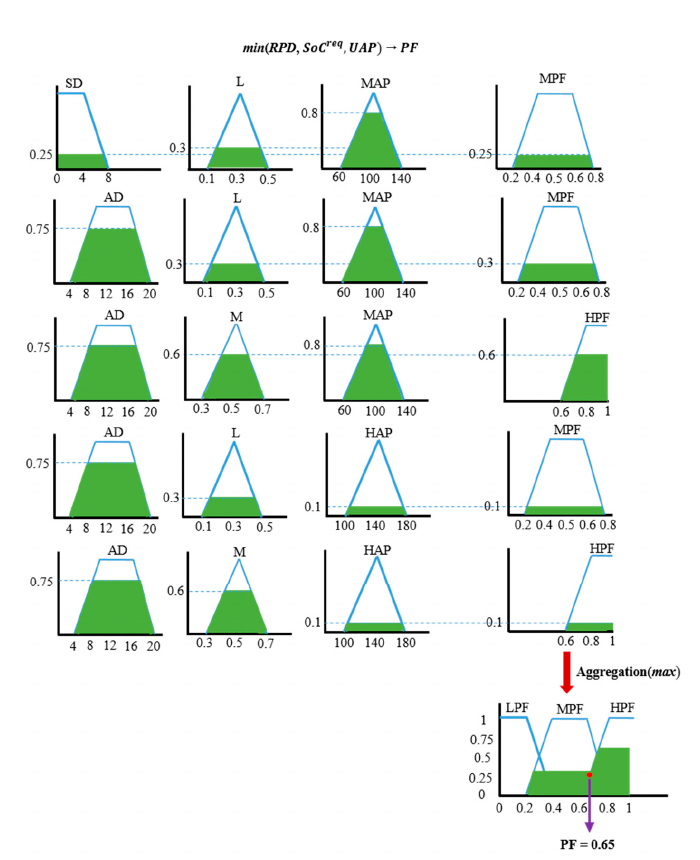
Figure 6. Illustration of min-max operation for calculating the value of the PF variable for an EV with PD = 7-time slots, SoC req = 28 kWh, and UAP = 105